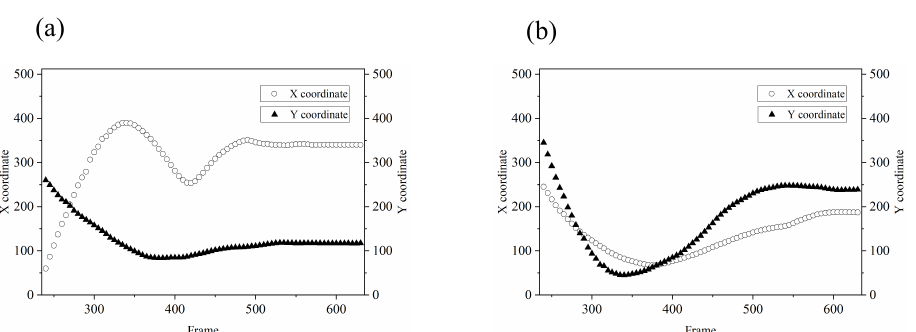
Figure 11. The estimated trajectories.